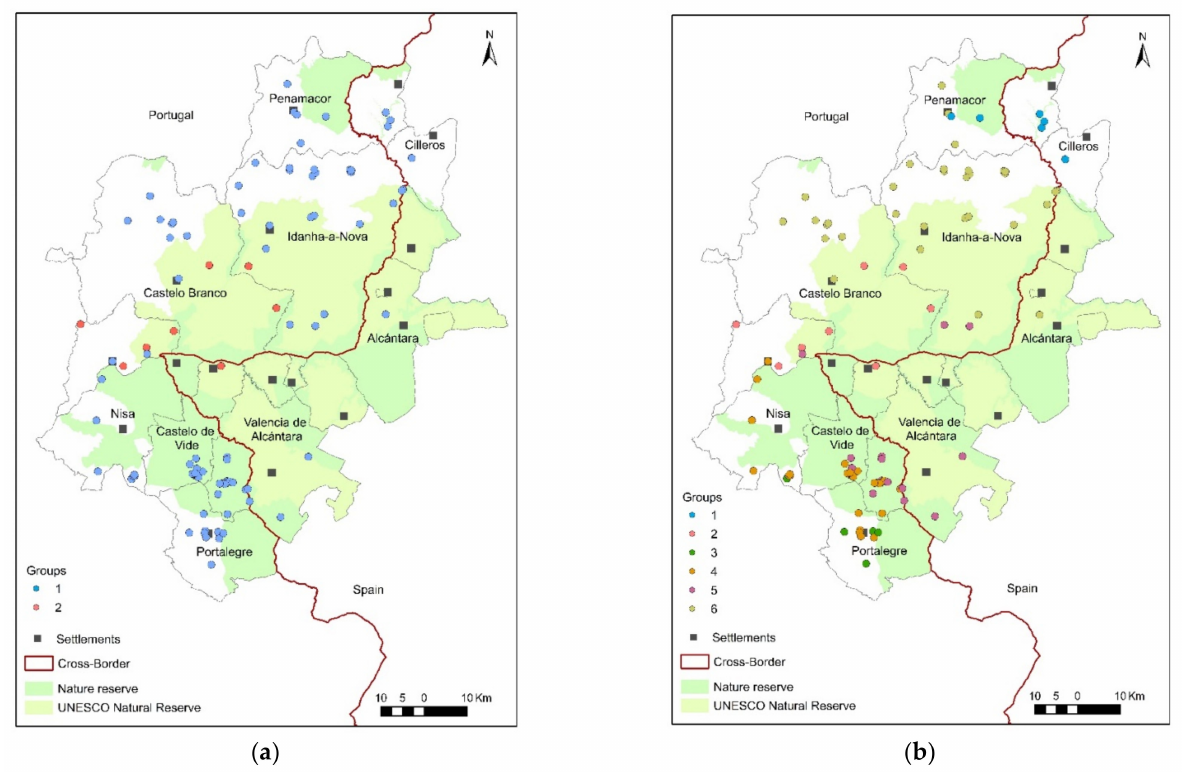
Figure 6. Territorial representation of the minimum spanning tree: ( a ) two groups; and ( b ) six groups.